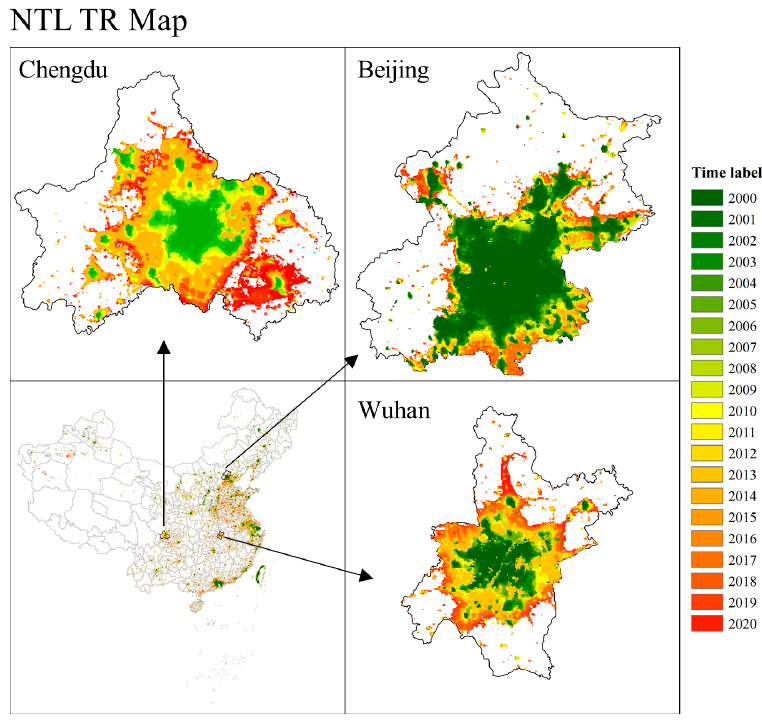
Figure 4. The urban NTL time ring (TR) map from 2000 to 2020 in China.